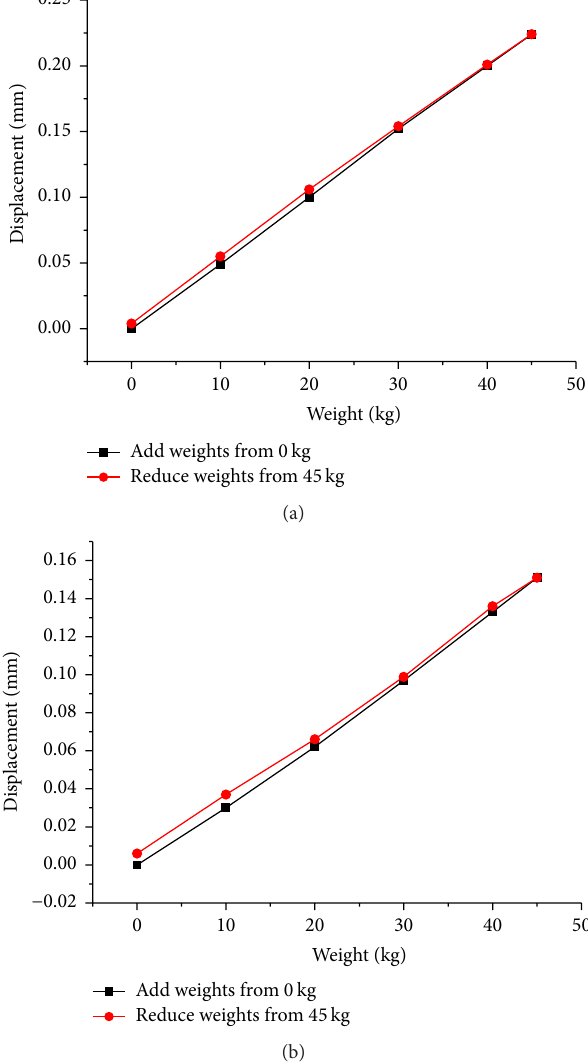
Figure 16: Displacement-weight curve for two bases: (a) the control base and (b) the verification